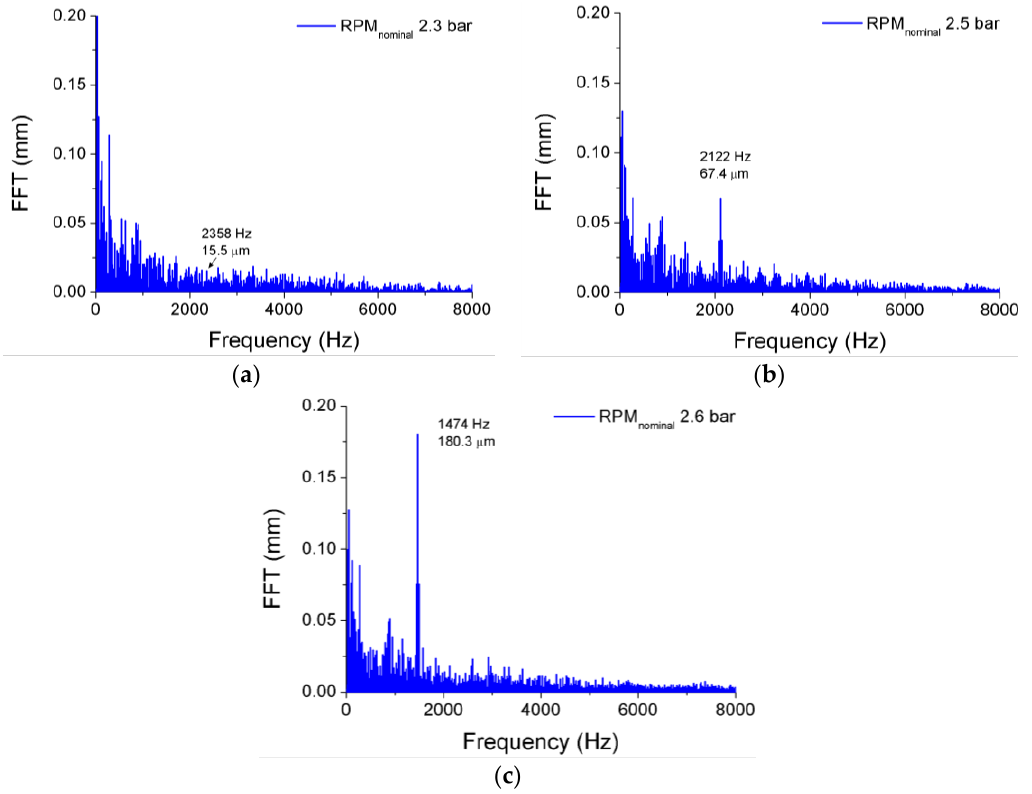
Figure 7. Evolution with the pressure difference of the vibration signal for the OFS 1 when the disk is rotating at RPM nominal .